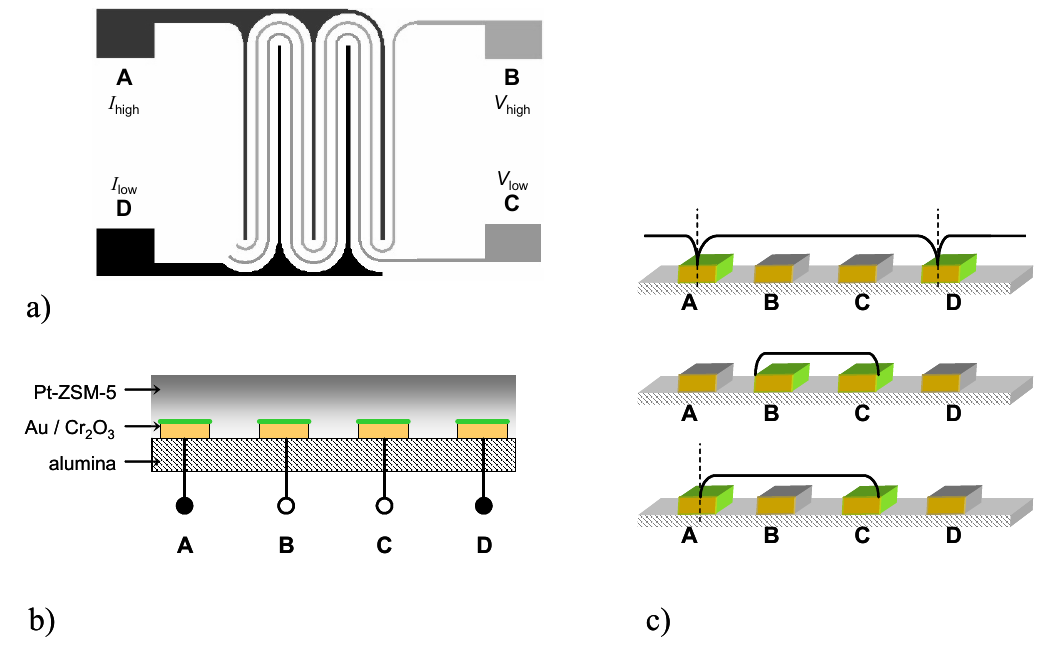
Figure 2. Some aspects of a planar four-wire interdigital electrode setup: a) Scheme of a planar four- wire interdigital electrode setup. b) Cross-section of the sensor setup. c) Sketch of the electrical field line in such an IDE capacitor depending on the connection